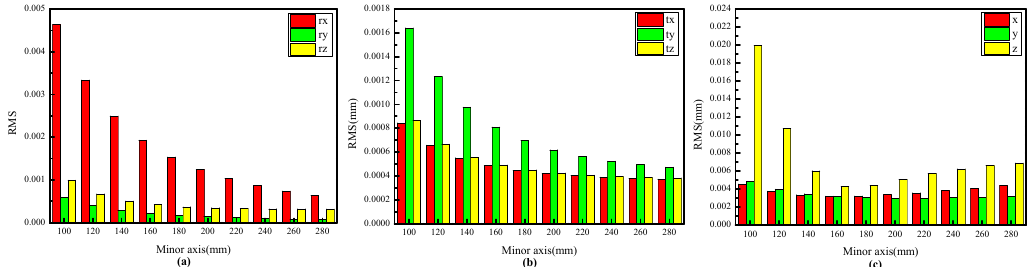
Figure 7. RMSEs of the extrinsic parameters based on the proposed method. ( a ) RMSEs of r x , r y and r z at different distance levels; ( b ) RMSEs of t x , t y and t z at different minor axis length levels; ( c ) RMSEs of the 3D coordinates of the characteristic points at different minor axis length levels.